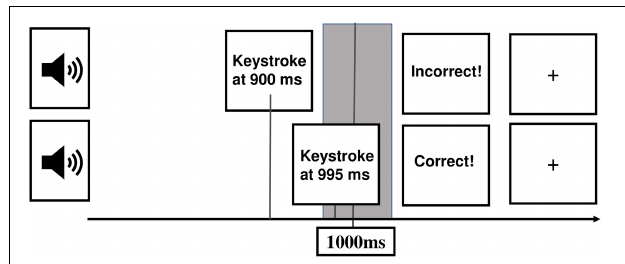
FIGURE 2 | Illustration of a sequence of a trial. From the left part to the right part: The presentation of a sound (1000 Hz, duration 50 ms) marked the beginning of a trial. Afterward, participants estimate the duration of 1 s and give their answer via keystroke. Direct feedback appears depending on whether the button was pressed in the tolerance time window (gray field) around 1000 ms (correct) or not (incorrect). A fixation cross with an inter-trial interval of 1400–1600 ms is presented before the start of a new